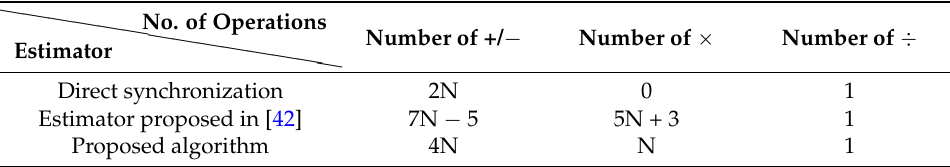
Table 1. Complexity comparison of different algorithms.